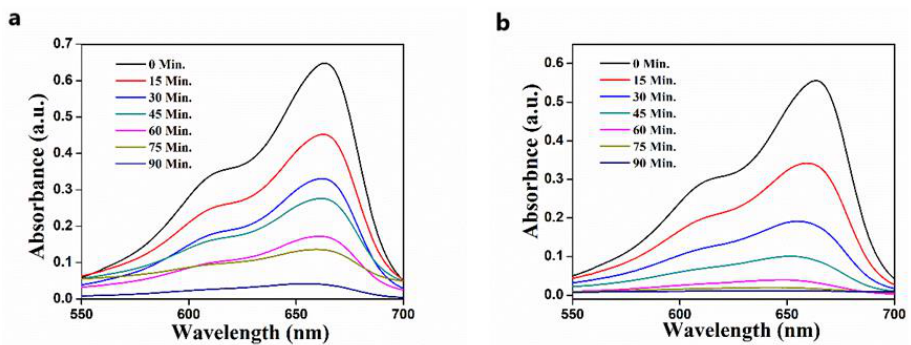
15 mg Figure 10. The effect of ZnO photocatalyst on % degradation of MB dye ( a ) with 5 mg ZnO; ( b ) with 15 mg ZnO.